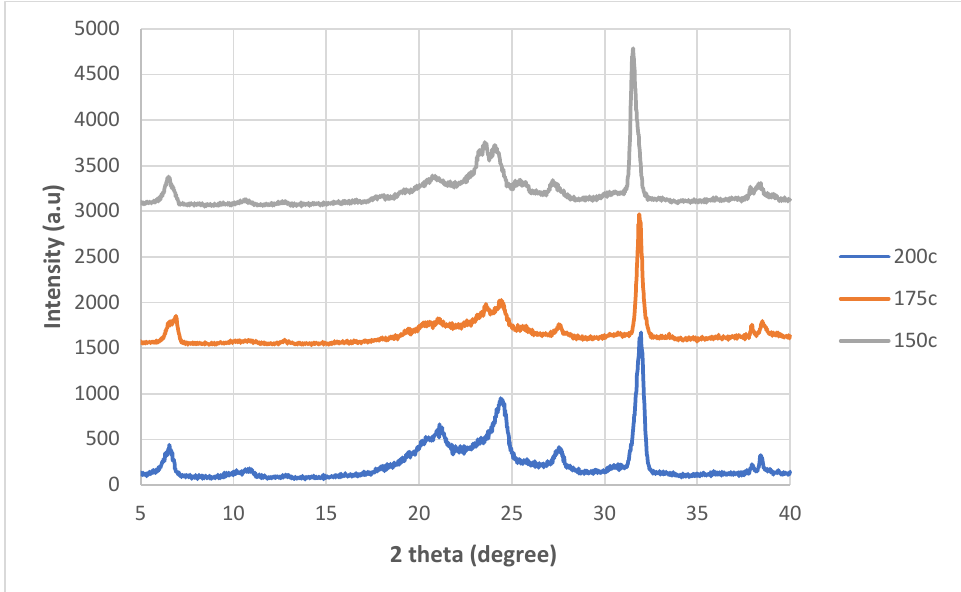
Figure 8. XRD Spectra of Spectra for Nylon 610 Nanocomposites with 1.5 wt% Graphite Nanosheets Treated at All Temperatures for Supercritical Water Treatment.